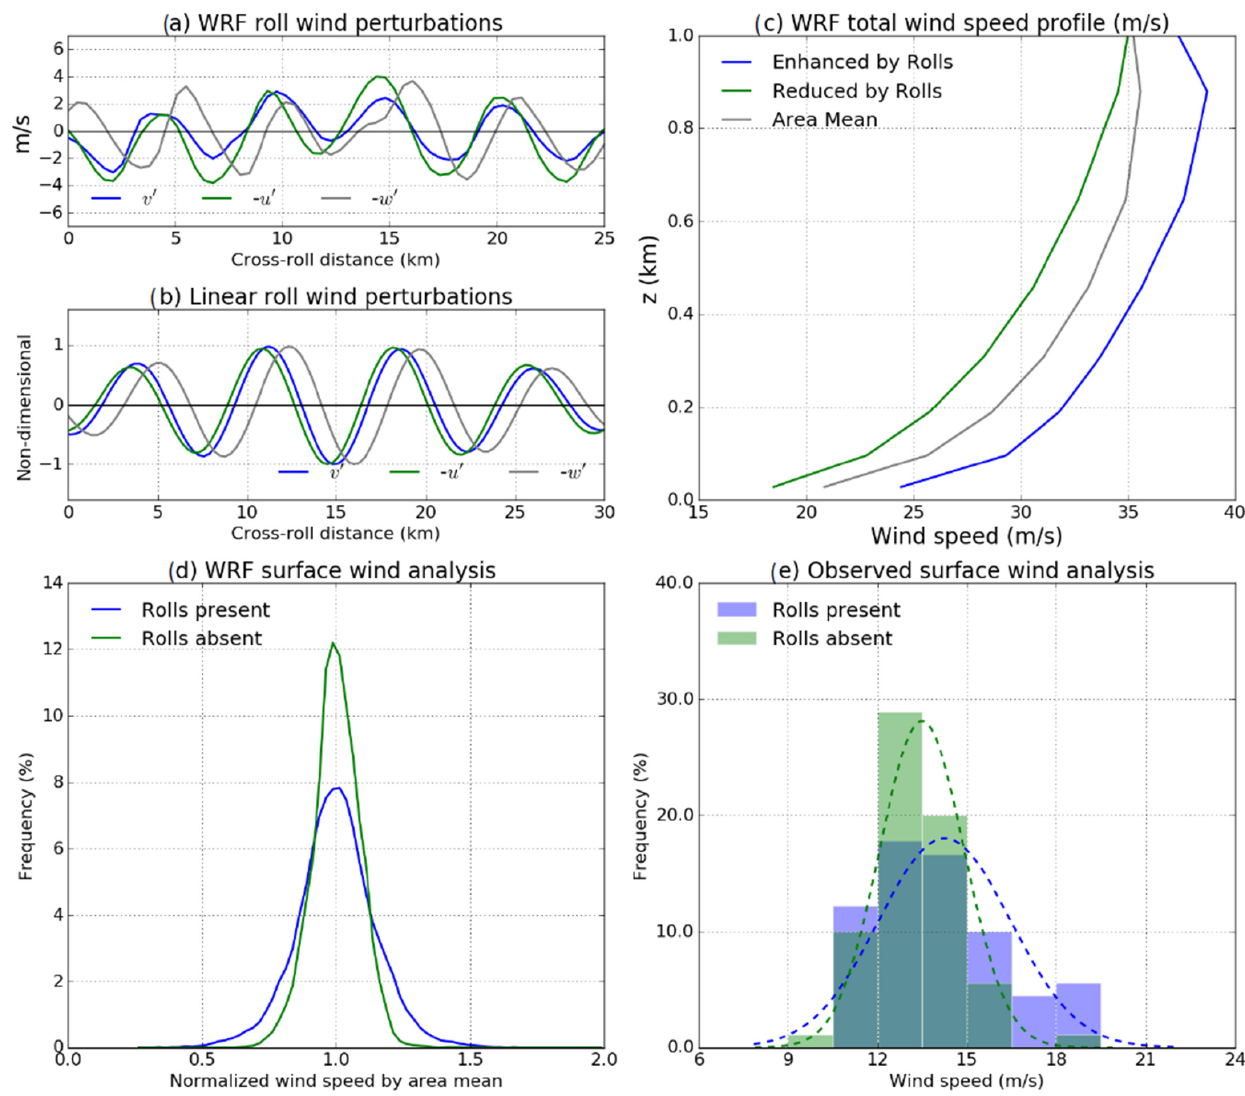
Figure 12. Impact of rolls on total surface wind speed. ( a ) The roll-induced tangential ( v ′ ) and radial ( u ′ ) wind speed perturbations at the lowest model level (approximately 30 m height) and the roll vertical velocity at 1 km height ( w ′ ) corresponding to the WRF cross sections shown in Figure 9d–f. Note the signs of u ′ and w ′ are reversed to better reveal the phase difference relative to v ′ . ( b ) Similar to ( a ) but from the linearized roll model as shown in Figure 9g–i. The three wind components from the linear model are normalized by their maximum values, respectively. ( c ) Representative profiles of total wind speed at the grid points where surface wind speed is enhanced and reduced by rolls in WRF, respectively. The gray line shows area mean profile for comparison. The data used for the analysis in ( a – c ) are the same as in Figure 9. ( d ) Probability density functions of surface wind speed in areas with and without rolls estimated from the WRF simulation (areas shown in Figure 8b). ( e ) Histograms of 10 m height wind observations measured at the National Oceanic and Atmospheric Administration (NOAA) Automated Surface Observing System station at Teterboro, NJ, during the periods with (blue color) and without (green color) propagating rolls. The overlapped areas are indicated by the dark color.